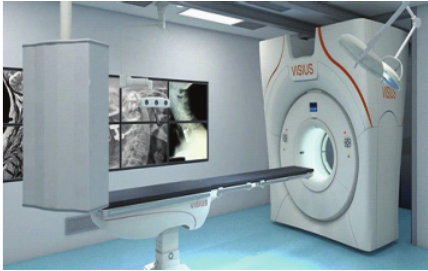
Figure 8: The ceiling-mounted intraoperative “VISIUS iCT”. Cour- tesy of IMRIS